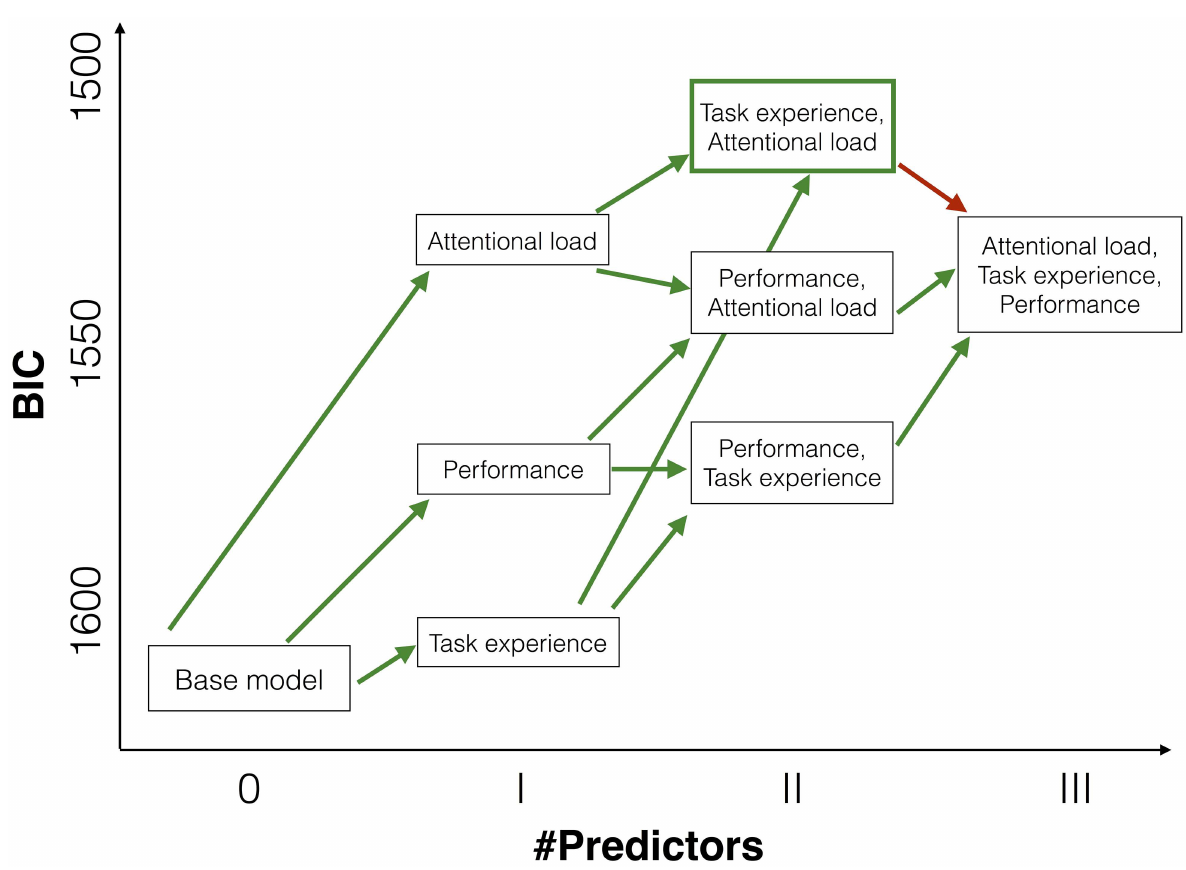
Fig 3. Model comparisons overview. The ordinateshows the model fit in form of the reportedBayesianinformationcriterion (BIC). The abscissa indicatesthe numberof predictors in the model. Green arrows indicatemodel additions that significantly explainedadditional varianceto the varianceexplained by previouspredictors. Red arrows indicate that the added predictors did not explainadditional